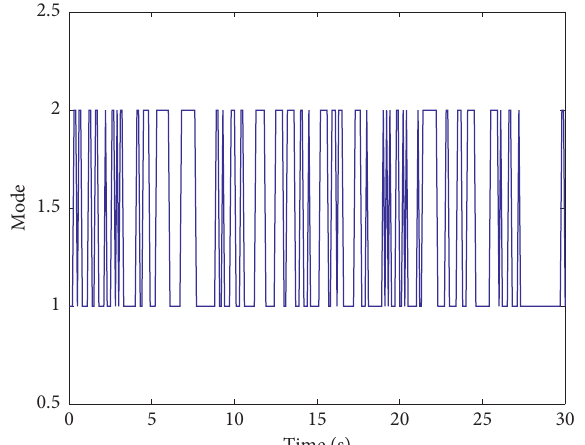
Figure 2: The state transition of Markov jump in Case 1.